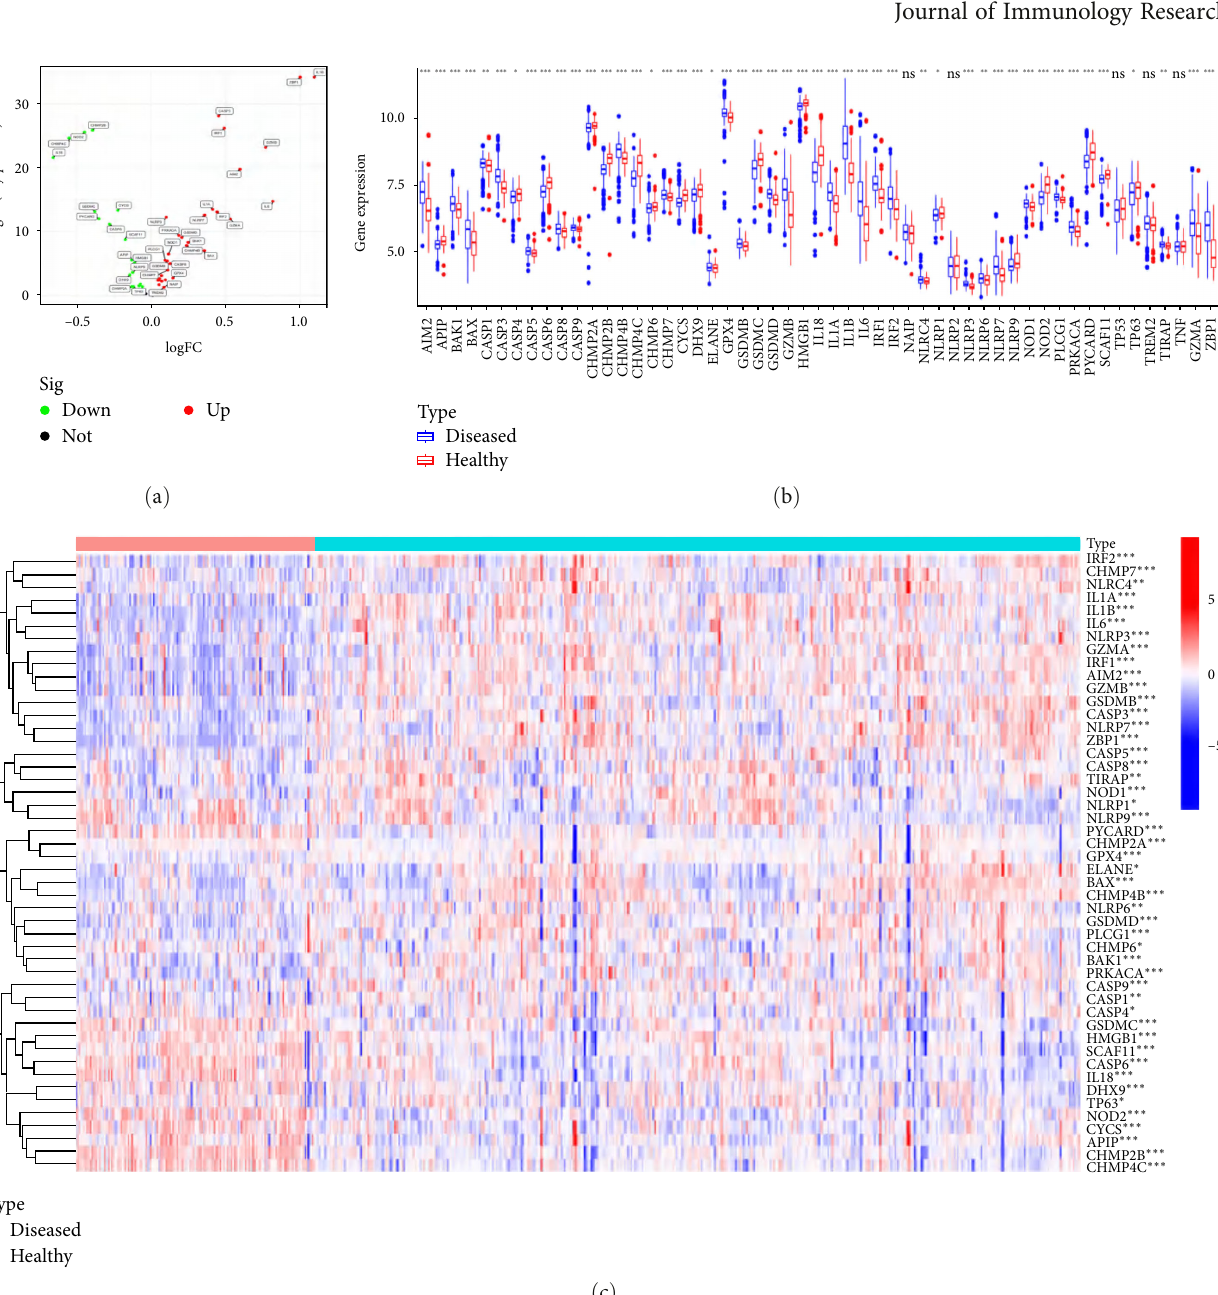
(Figure 2(a) – 2(c)). Visualization of chromosomal positions in PRGs was achieved using the “ RCircos ” package (Figure